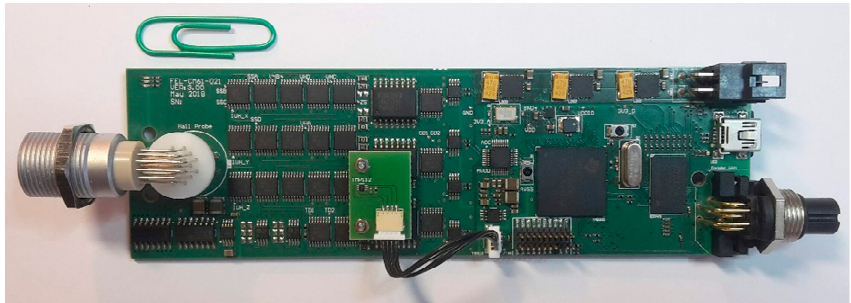
Figure 3. Top view of the eight-layer PCB, the left side comprises the analogue circuitry with the Hall probe connector at the extreme left, the ADC and the microcontroller somewhat in the middle of the board and the power supply connector, USB and encoder connector on the right hand side of the board.